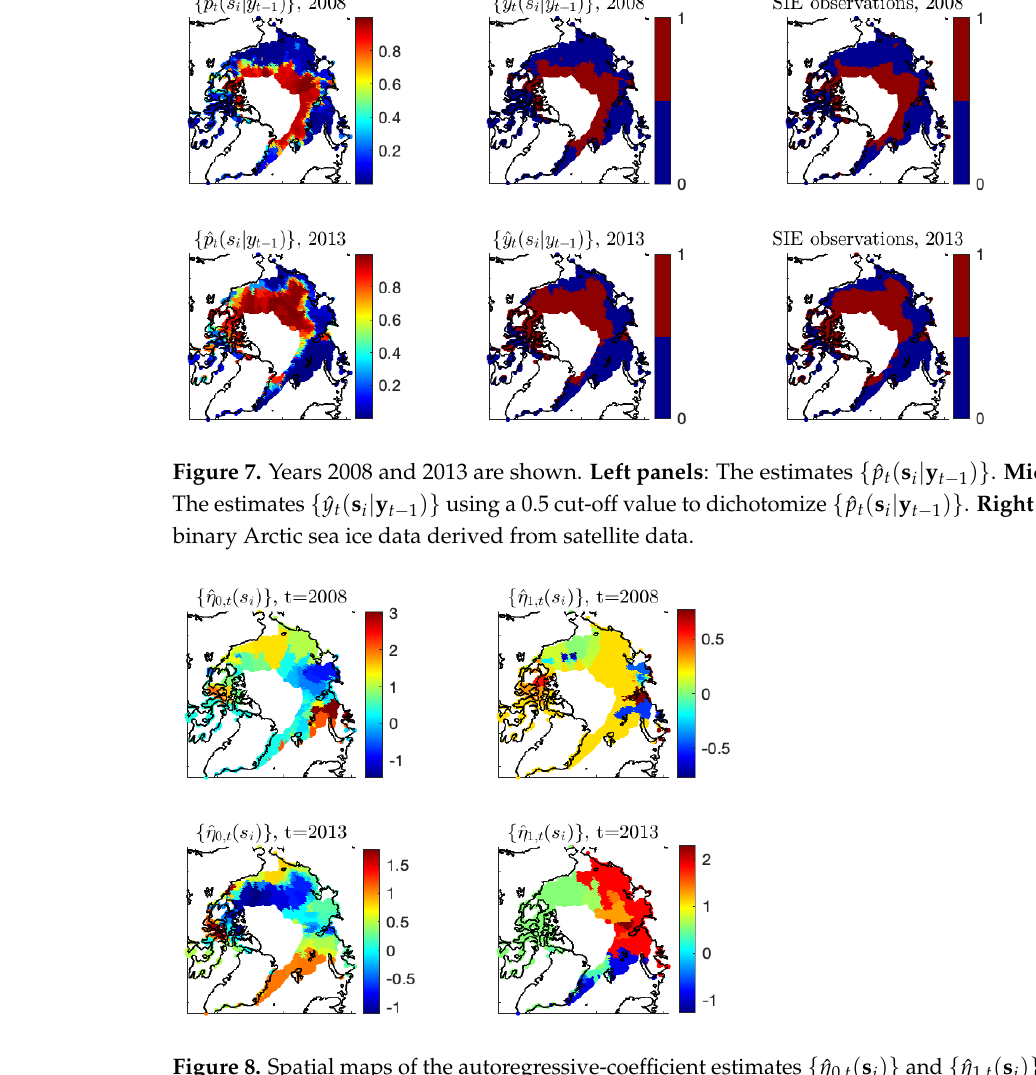
Figure 8. Spatial maps of the autoregressive-coefficient estimates { ˆ η 0, t ( s i ) } and { ˆ η 1, t ( s i ) } for the best model at t = 2008 and t =